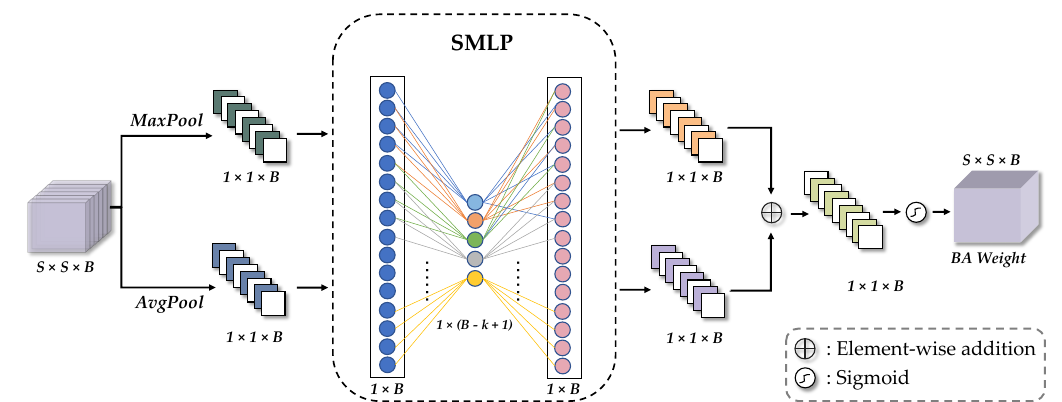
Figure 2. The proposed GBAM